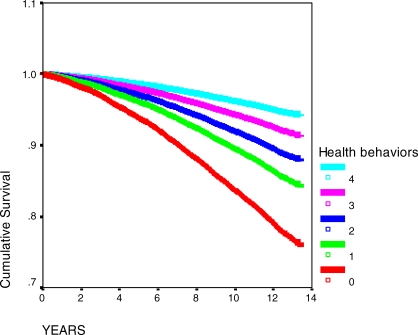
Survival Function According to Number of Health Behaviours in Men and Women Aged 45–79 Years without Known Cardiovascular Disease or Cancer, Adjusted for Age, Sex, Body Mass Index and Social Class, EPIC-Norfolk 1993–2006